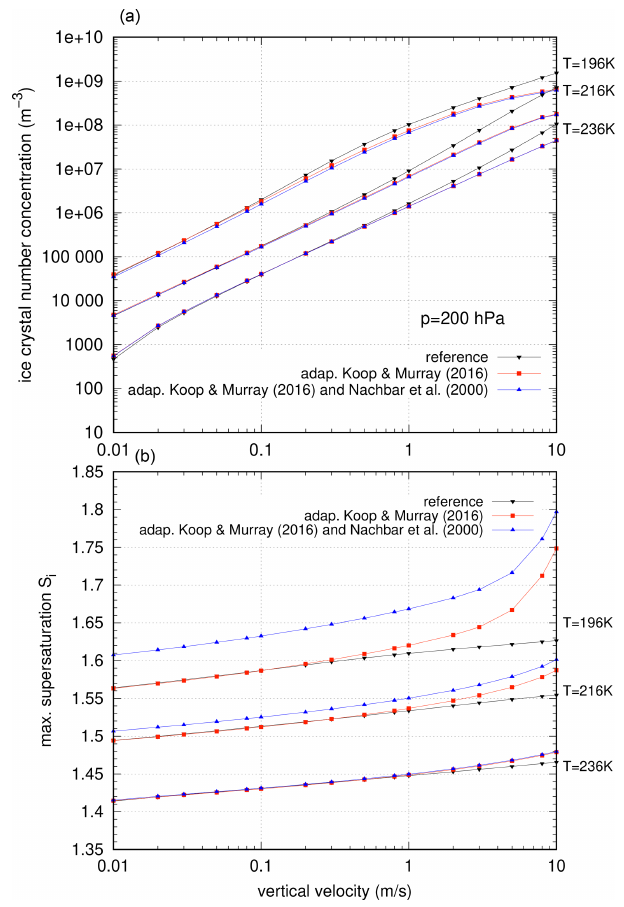
Figure 12. Impact of the direct formulation of the nucleation rate based on Koop and Murray (2016) on the idealized nucleation events. Black triangles and lines indicate the reference simulation, red squares and lines denote the use of the nucleation rate based on Koop and Murray (2016), and blue squares and lines represent the use of the nucleation rate based on Koop and Murray (2016) together with the saturation vapour pressure due to Nachbar et al. (2019). (a) Ice crystal number concentrations and (b) maximum su- persaturation